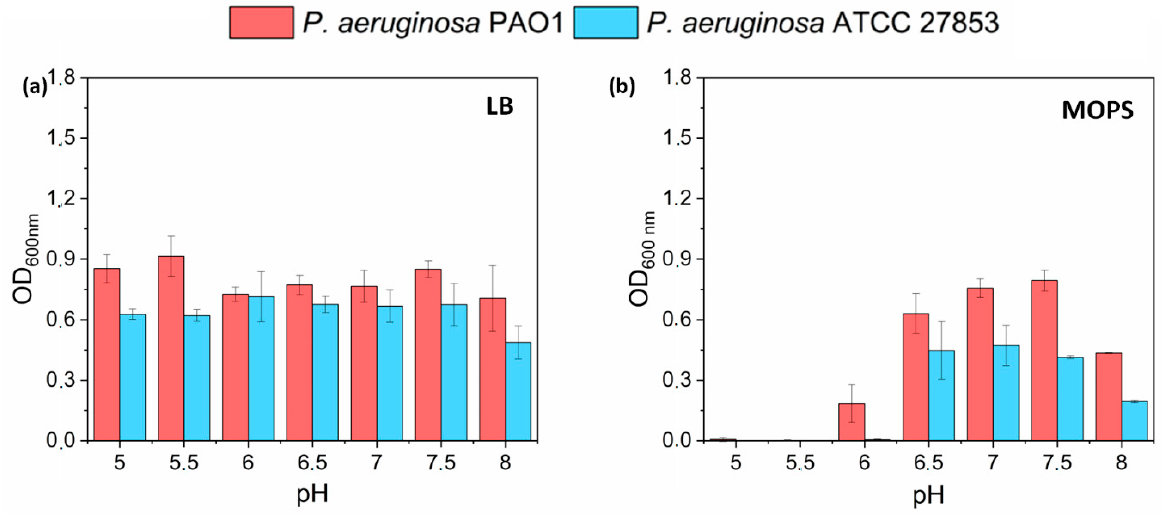
Figure 5. pH-dependent growth of P. aeruginosa PAO1 and ATCC 27853 strains in ( a ), LB ( b ), MOPS medium (mean ± sd, n = 3; for statistical analysis see Supplementary Materials Table S3).